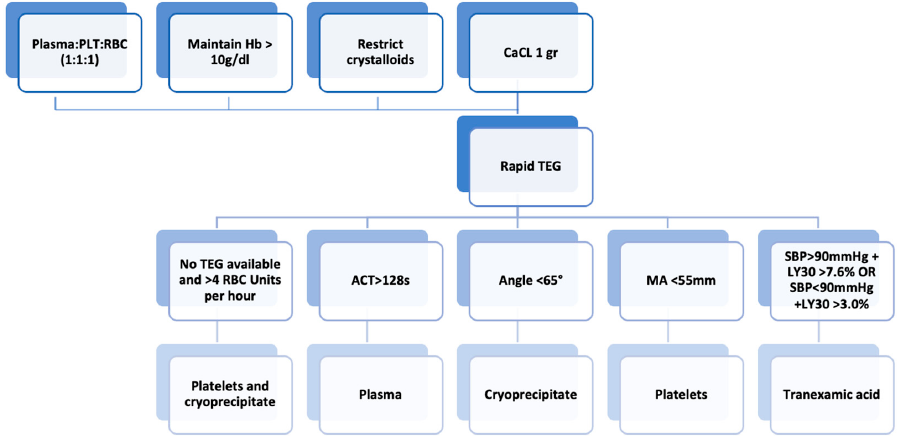
Figure 5. Subsequent management of trauma-induced coagulopathy. Abbreviations: ACT, activated clotting time; aPTT, activated partial thromboplastin time; CCA, conventional coagulation assay; LY30, percentage reduction in the area under the curve at 30 min after MA in TEG; MA, maximum amplitude; PT, prothrombin time; RBC, red blood cell; SBP, systolic blood pressure; VHA, viscoelastic hemostatic assay.